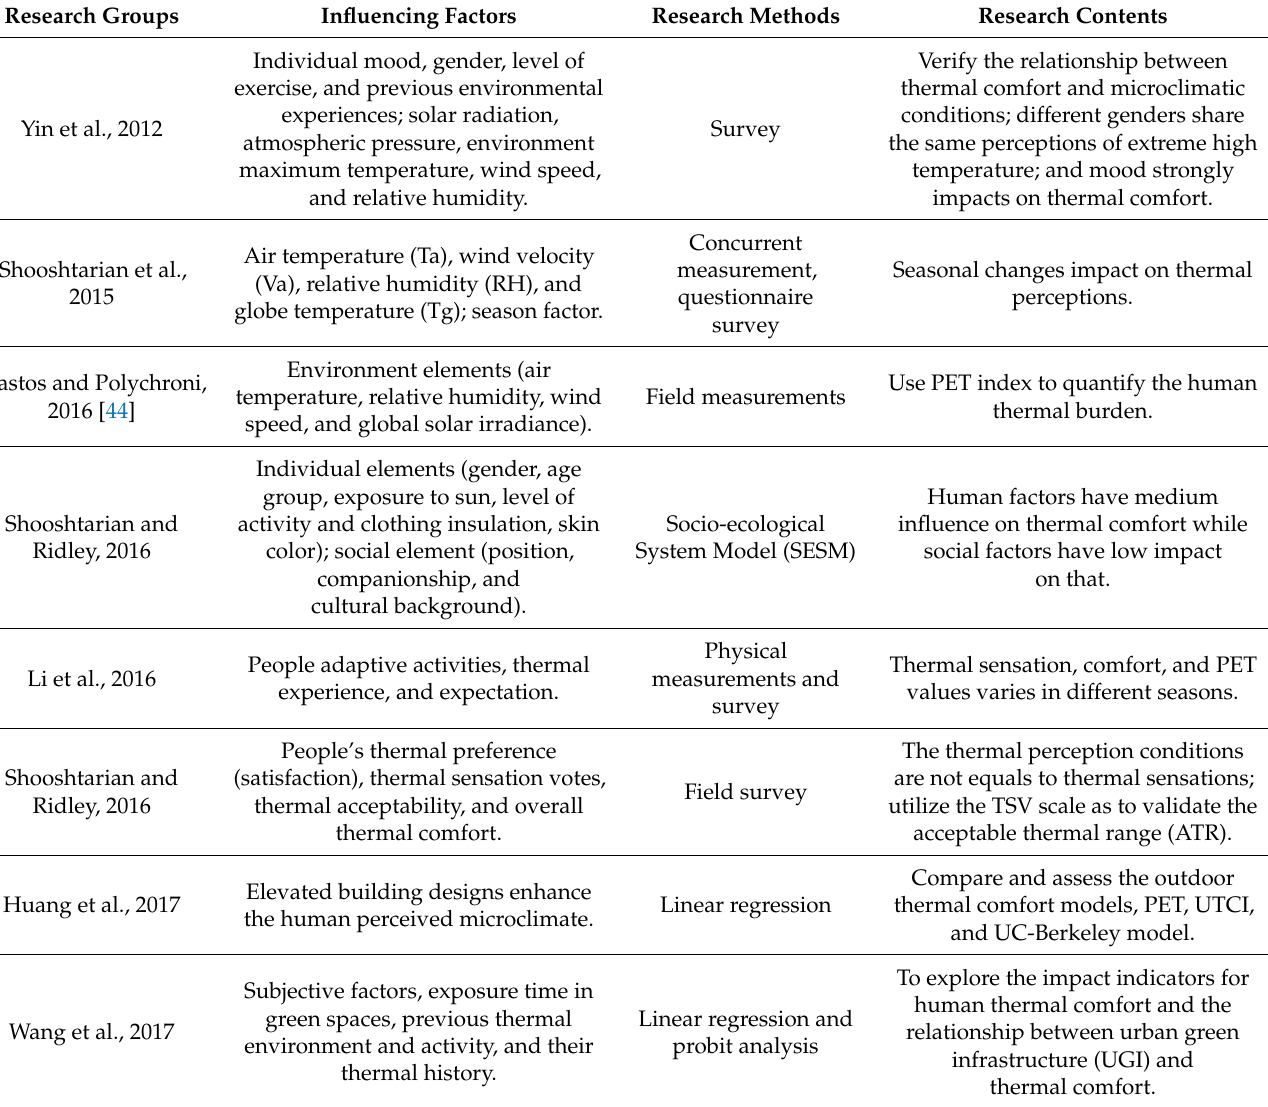
Table 1. The influential factors and research methods of thermal comfort perceptions on the